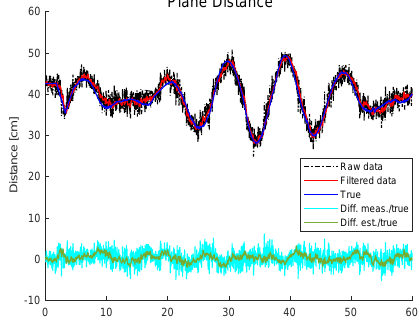
Figure 10: The plot shows the plane distances based on raw measurements, filtered data based on the scheme in Figure 2, and the true dis- tance. Moreover, two error plots are added, namely the difference between the measured plane distances and the true values, and the estimated distances and the true values.